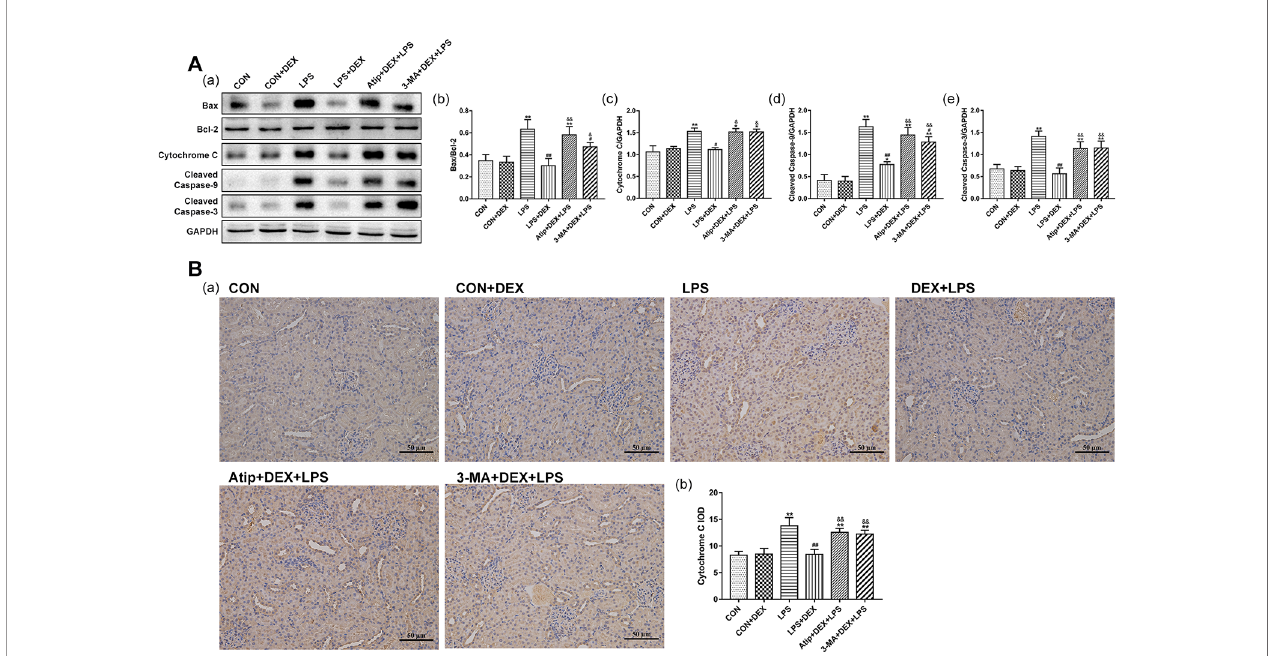
FIGURE 5 | Effects of DEX on apoptosis related proteins. (A) Representative blots (a) of Bax, Bcl-2, Cyt C, cleaved caspase-9, and cleaved caspase-3, and the densitometry of Bax/Bcl-2 (b), Cyt C (c), cleaved caspase-9 (d), and cleaved caspase-3 (e) signals. (B) Representative images of Cyt C IHC (a), and quantitative analysis of Cyt C (b) in kidney. Data are expressed as mean ± SEM (n = 6). **p < 0.01 versus CON group. #p < 0.05, ##p < 0.01 versus LPS group. &p < 0.05, &&p < 0.01 versus DEX + LPS